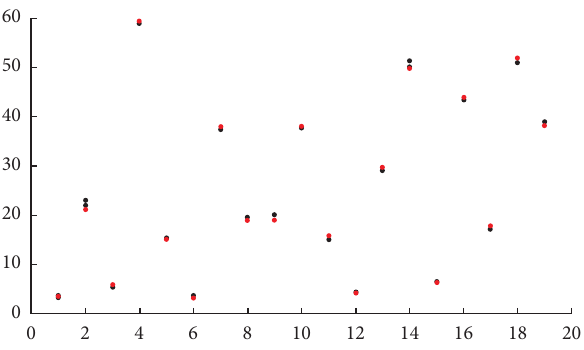
Figure 1: Daily weight on day 1 (red dot) and on other days (black dot) ( y -axis) against the selected patient ( x -axis); when the black dot appears, the weight on day t is different from that of day